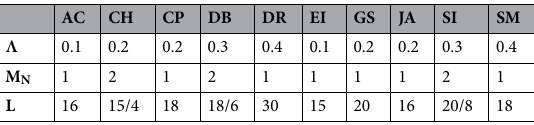
Table 1. Masking parameters for different categories.